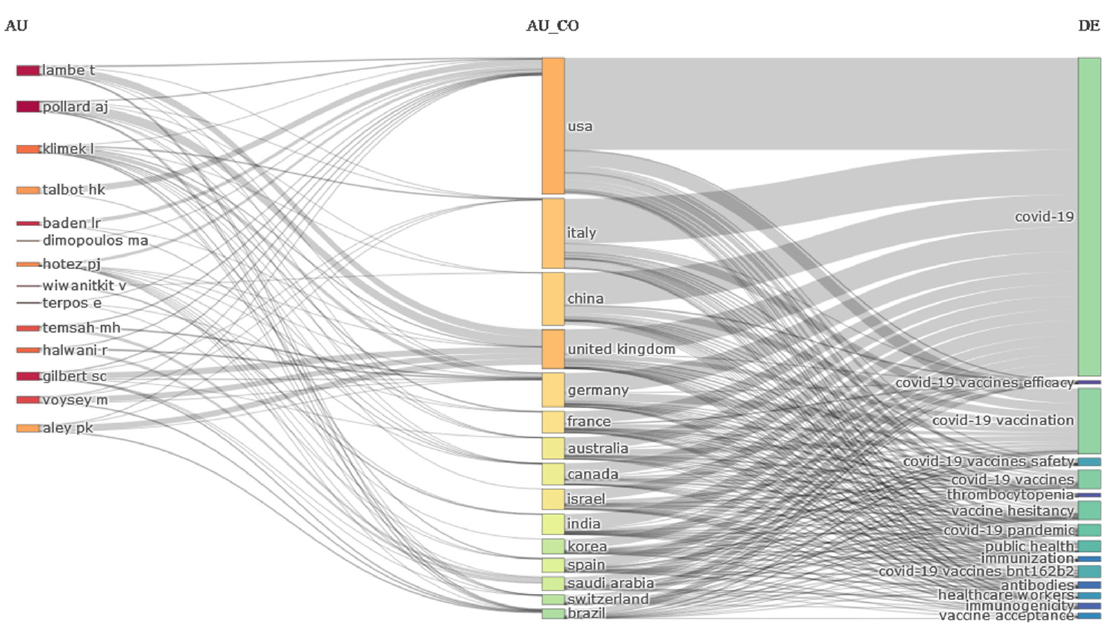
Figure 4. Three-field plot for the relationships among authors, countries, and author keywords in COVID-19 vaccine research. (AU: Author, Au_CO: Author country, DE: Document keyword).